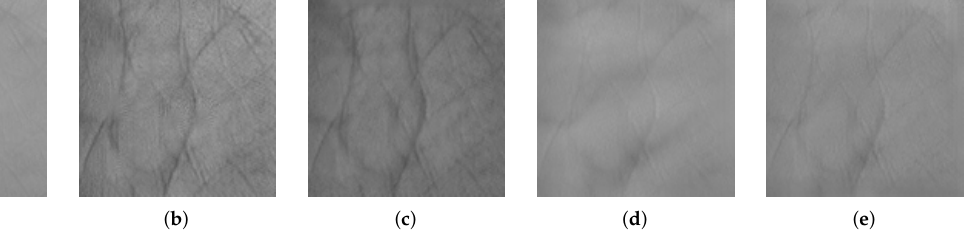
Figure 4. Star-GAN results example: ( a ) is the NIR input palmprint image, ( b – e ) are the translated results to blue, green, NIR, and red spectrum.